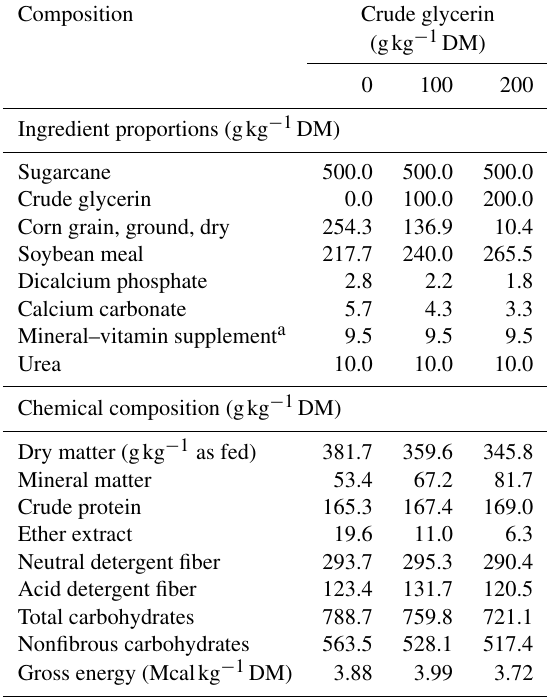
Table 1. Ingredients and chemical composition of experimental di- ets.